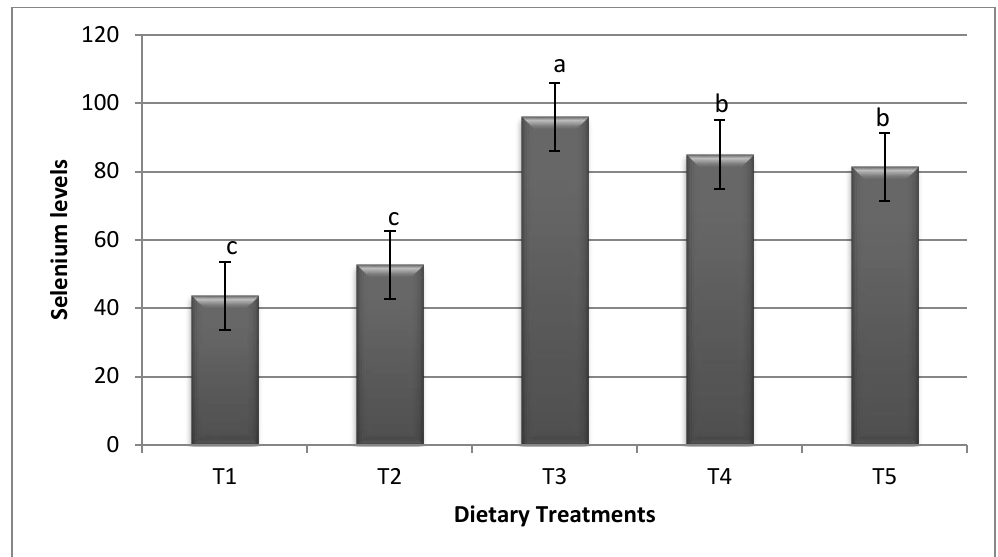
Figure 1. Effect of inorganic selenium and different sources of bacterial selenoprotein on breast meat Figure 1. E ff ect of inorganic selenium and di ff erent sources of bacterial selenoprotein on breast meat selenium concentration (µg/kg). a,b,c Means in the same bar with different superscripts are significantly selenium concentration ( µ g / kg). a,b,c Means in the same bar with di ff erent superscripts are significantly different (<0.05). T1: basal diet, T2: basal diet + 0.3 mg/kg feed sodium selenite, T3: basal diet + 0.3 di ff erent ( < 0.05). T1: basal diet, T2: basal diet + 0.3 mg / kg feed sodium selenite, T3: basal diet + 0.3 mg / kg